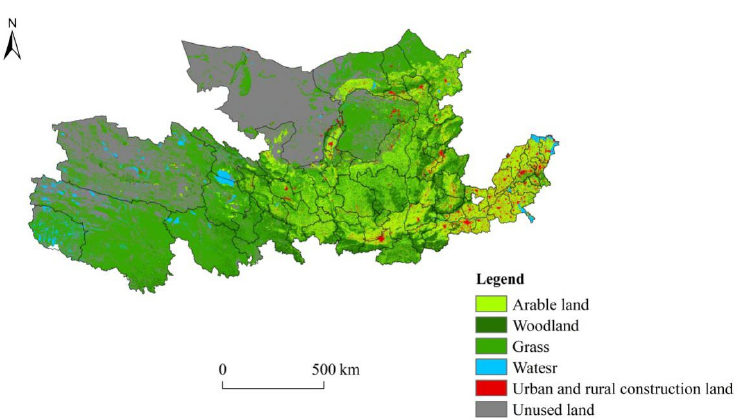
Figure 2. Land use map of the Yellow River Basin in 2018.